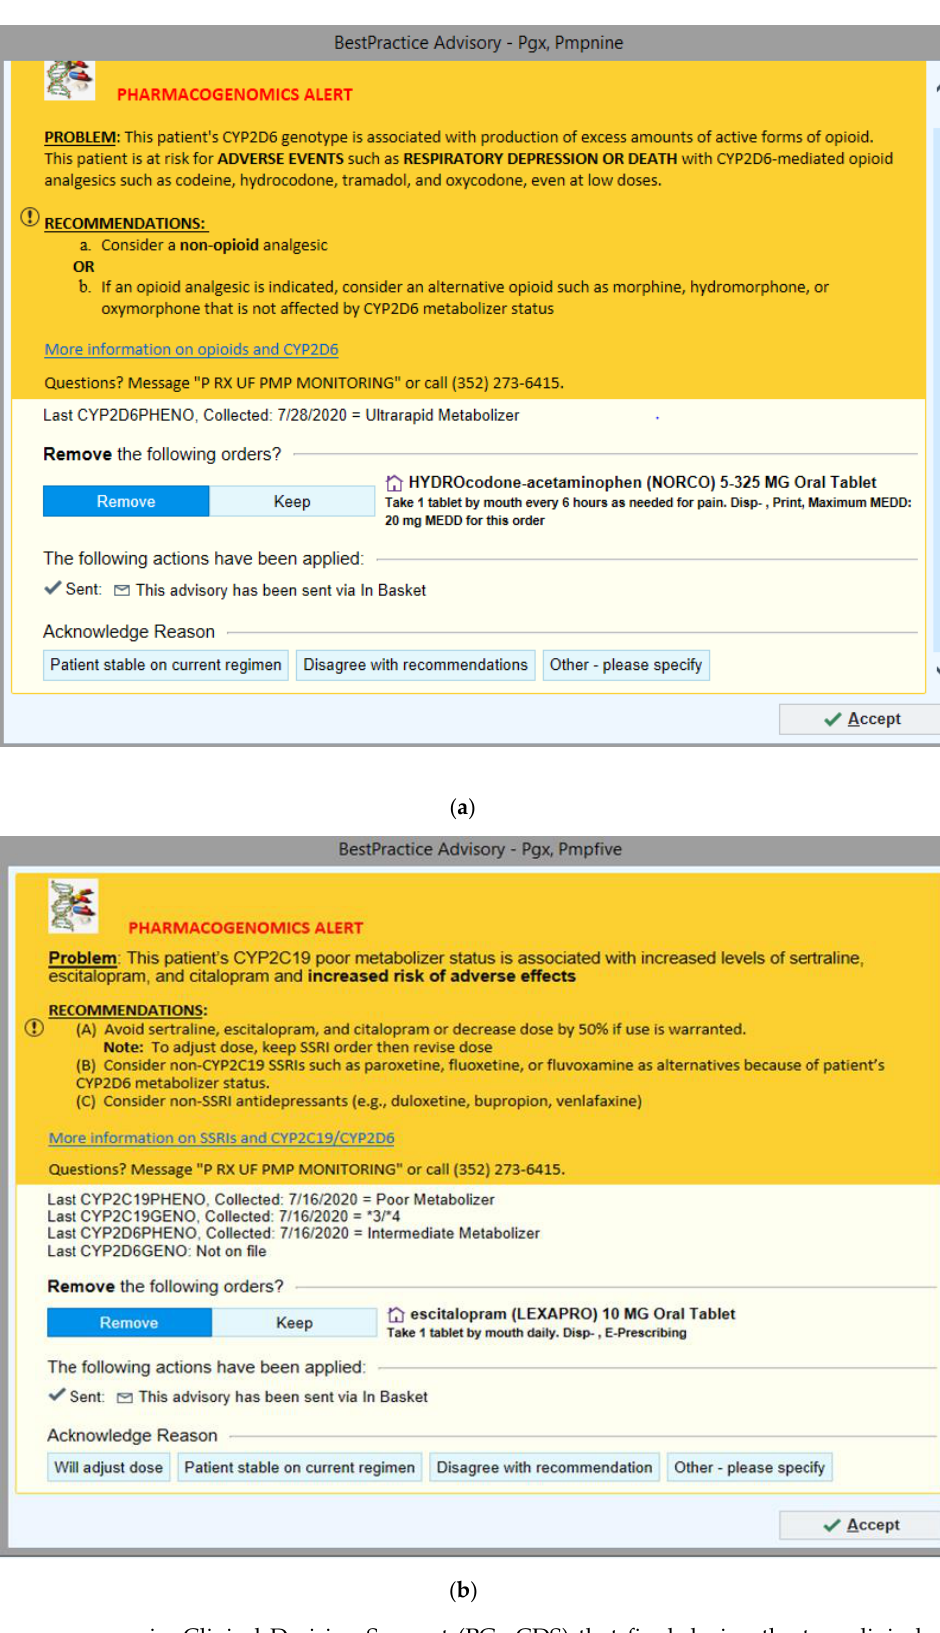
Figure 1. Pharmacogenomics-Clinical Decision Support (PGx-CDS) that fired during the two clinical scenarios. ( a ) Hydrocodone-acetaminophen prescribed to a patient with a CYP2D6 ultrarapid metabolizer (UM) phenotype; ( b ) escitalopram prescribed to a patient with CYP2D6 intermediate metabolizer (IM) and CYP2C19 poor metabolizer (PM)